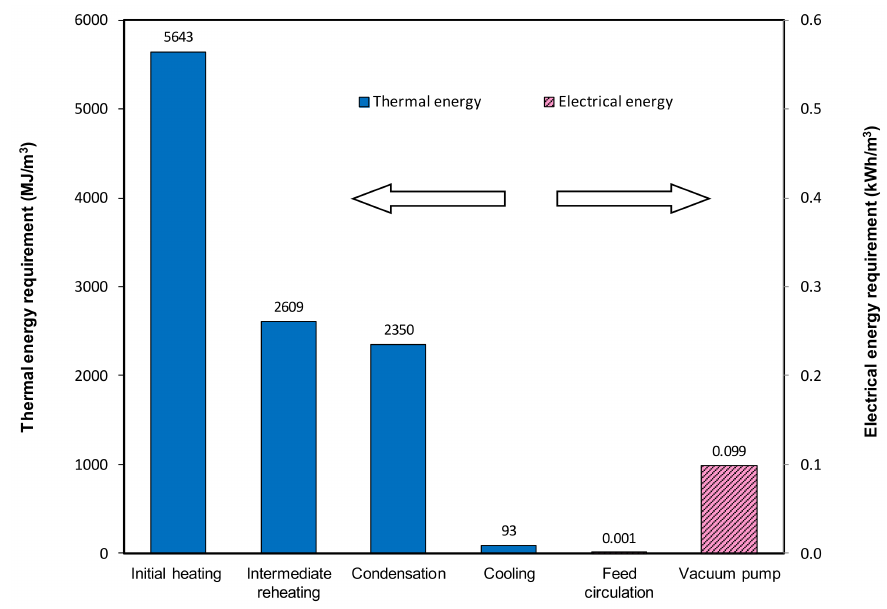
Figure 5. Breakdown of thermal and electrical energy requirement for PV process per m 3 of permeate produced in recirculation mode (feed temperature 65 ◦ C, feed velocity 0.05 m/s, vacuum 6